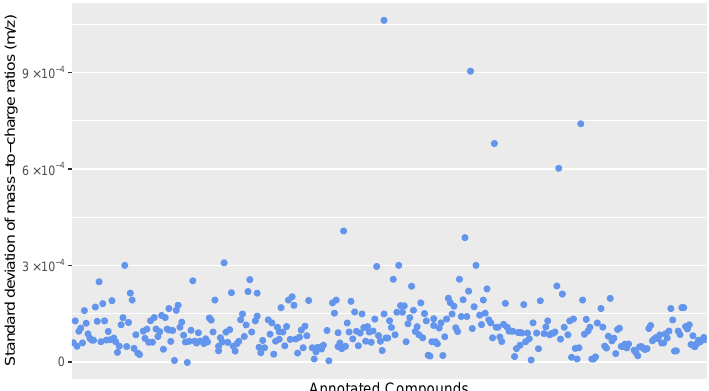
Figure A1. Scatter plot of the standard deviation of mass-to-charge ratios for all annotated compounds in the calibration standards.